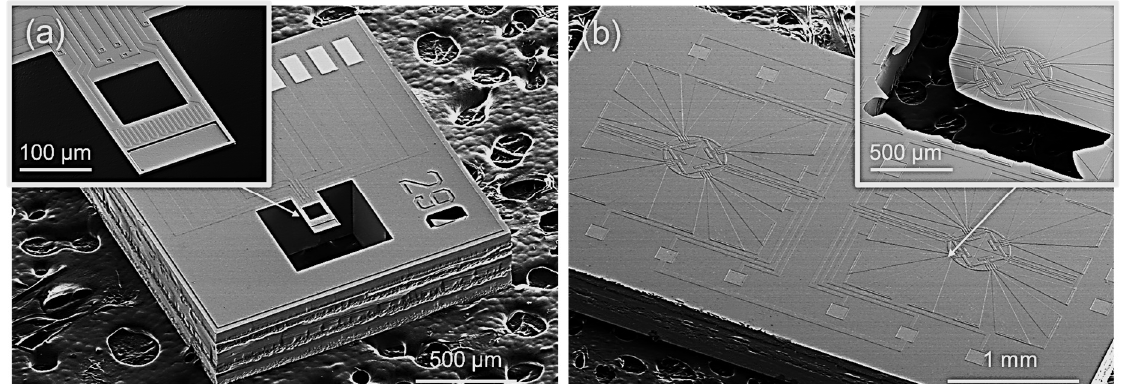
Figure 4. SEM images of the two chips for TG/DTA microsystem. ( a ) MR-TGA chip with the inset showing the magnified view of the cantilever. ( b ) Thermopile-integrated DTA chip with the inset showing the intentionally disrupted suspended diaphragm.